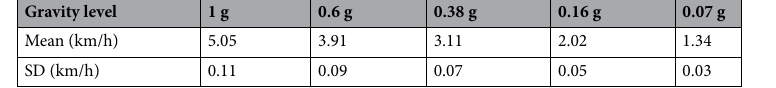
Table 1. Treadmill speed determined by the Froude number ( Fr ) corresponding to 0.25.